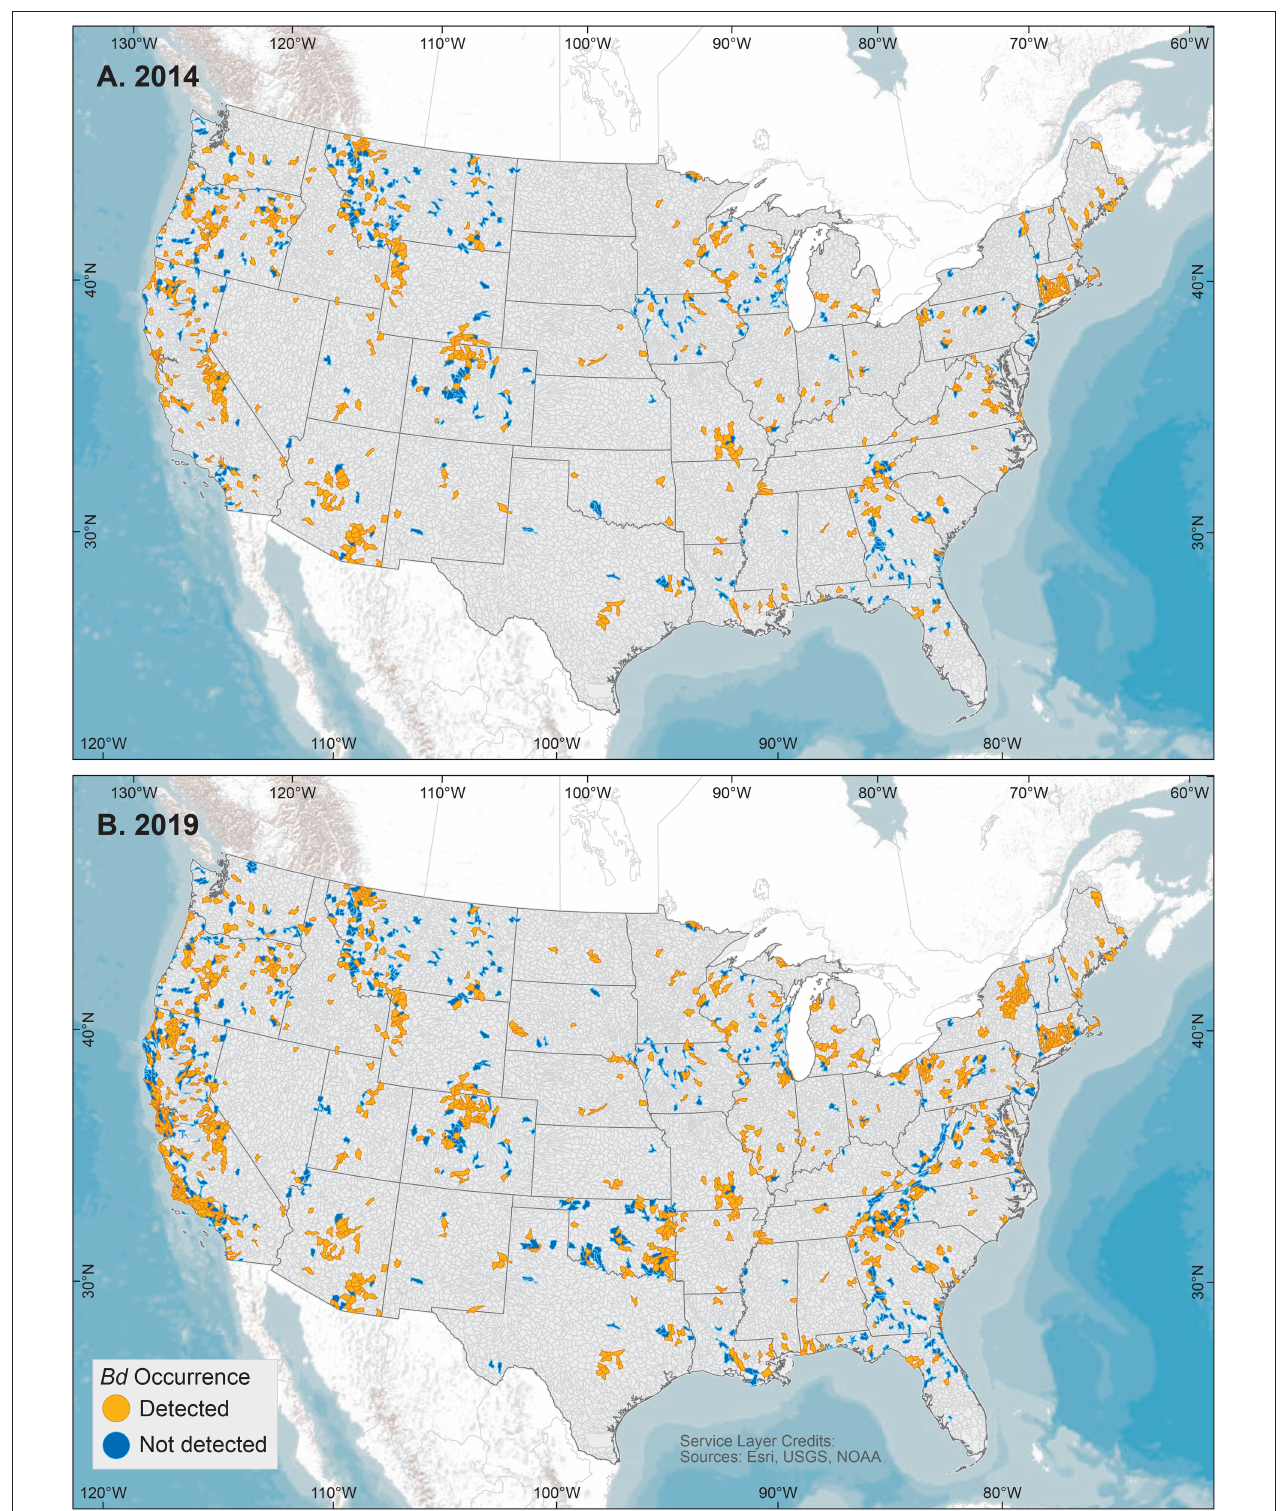
FIGURE 3 | United States 5 th -field hydrologic unit code watershed maps of Batrachochytrium dendrobatidis ( Bd ) occurrences from data compiled for the Global Bd Mapping project through: (A) June 2014 (42); and (B) December 2019. Watersheds shown with Bd detections also may have sampling results with no detection.